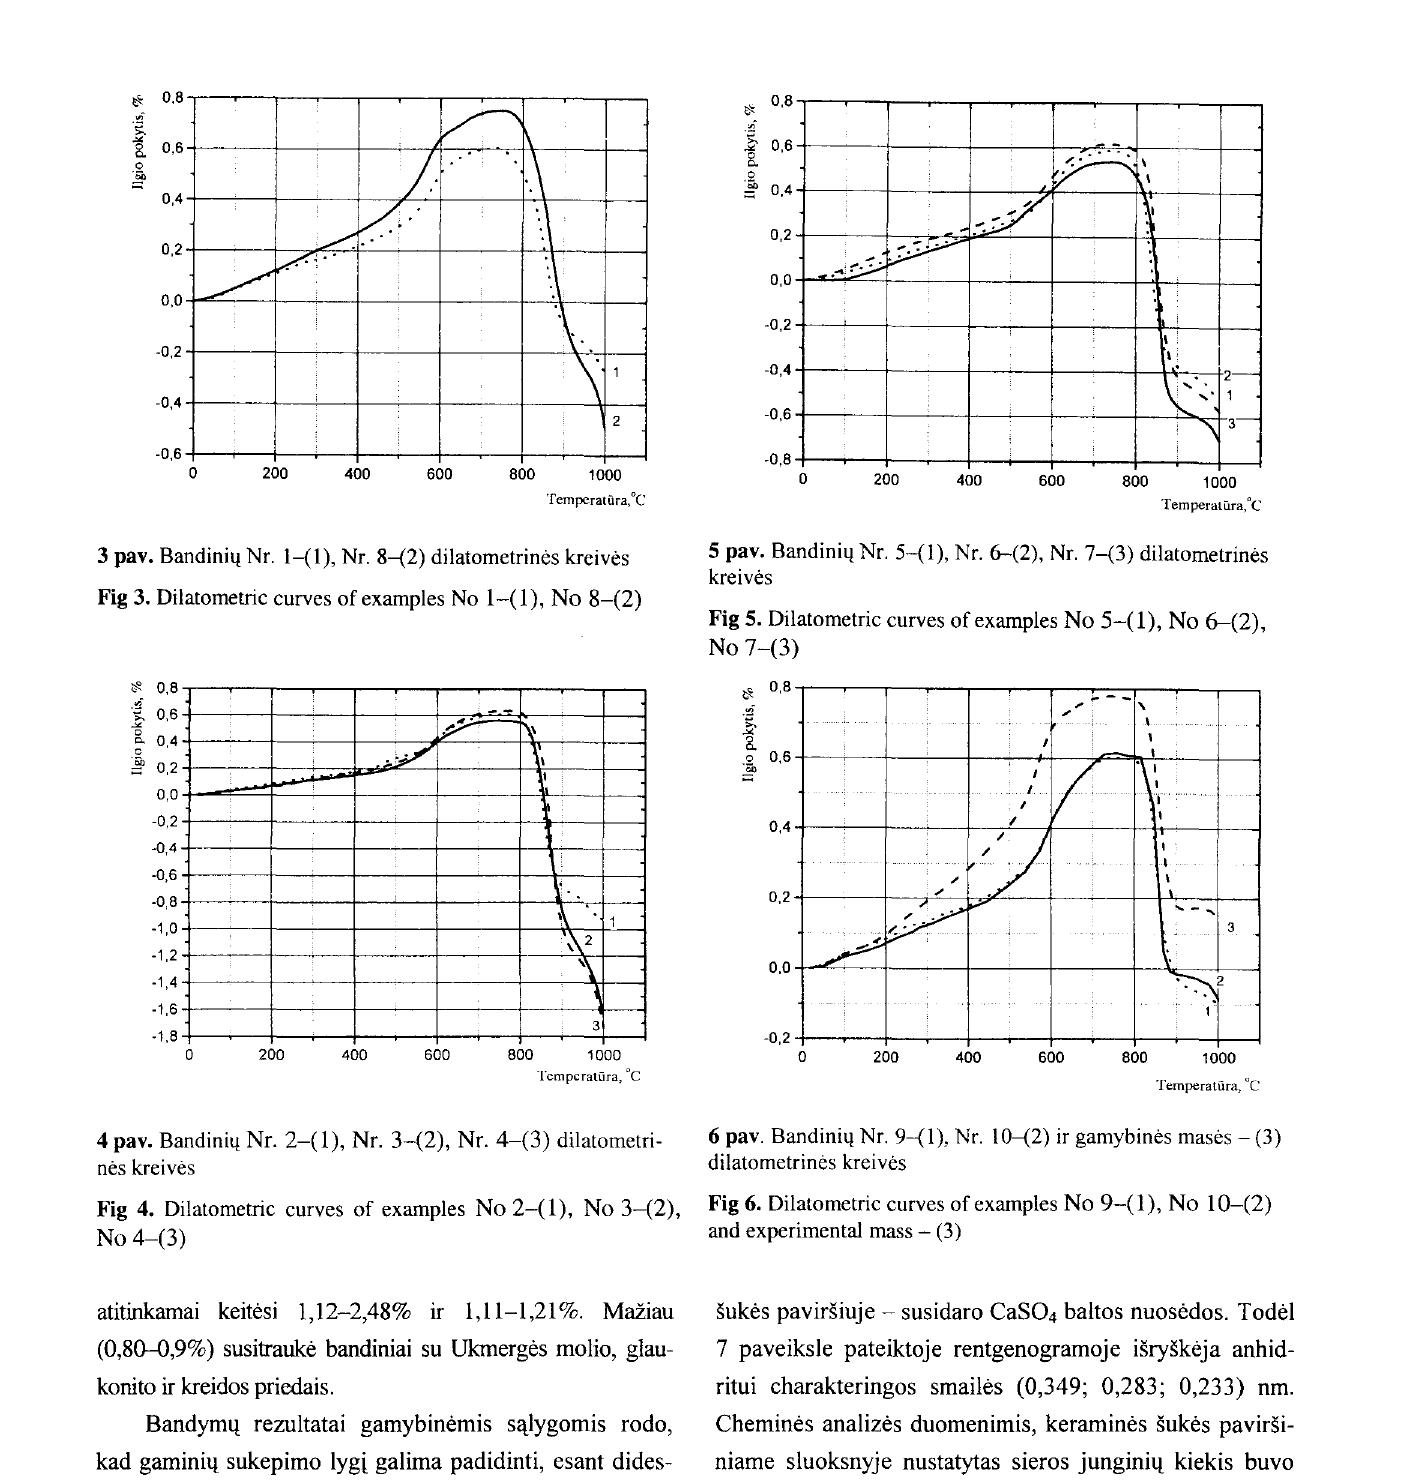
Fig 4. Dilatometric curves of examples No 2-(1), No 3-(2), No 4-(3) atitinkamai keitesi 1,12-2,48% ir 1,11-1,21%. M<lZiau (0,80-0,9%) susitrauke bandiniai su Ukmerges molio, glau konito ir kreidos priedais.